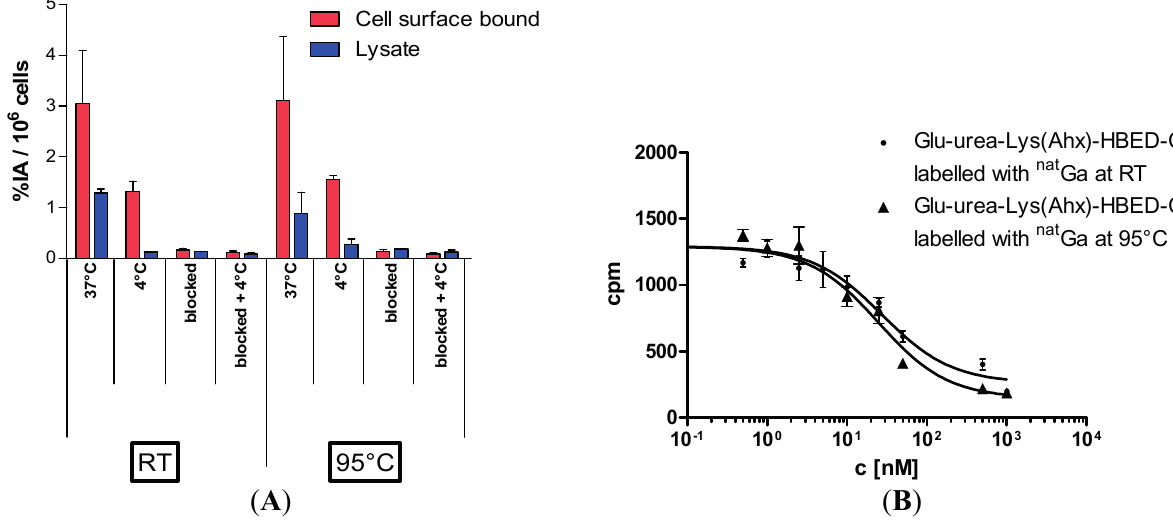
Scheme 3. Synthesis of cyclohexyldiethylenetriamine pentaacetic acid (5 S ,8 S ,22 S ,26 S